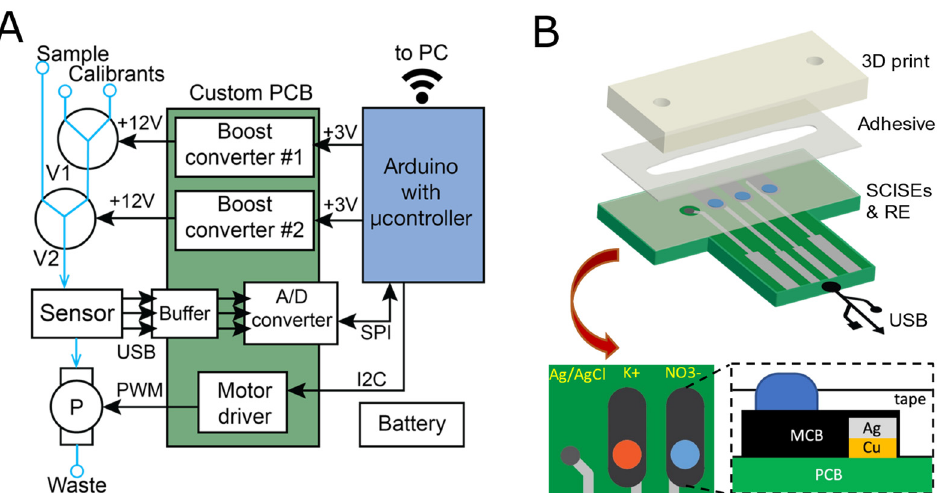
Figure 1. Design of the integrated SCISE sensor system. The system consists of a multiplexed SCISE sensor and a custom PCB for sensor readout and calibration: ( A ) Block diagram of the system illustrates the custom PCB circuit (center) and the supporting fluidic components. Arduino (right side) was used for device control and data transmission. Solenoid valves (V1, V2) and peristaltic pump (P) formed the fluidic circuit (left side). ( B ) Schematic illustration of the multiplexed sensor showing microfluidic integration, sensor layout, and the cross-sectional view of the sensing layers. Note the lateral shift of the ion-selective membrane on top of the mesoporous carbon black (MCB) layer to prevent water layer formation.